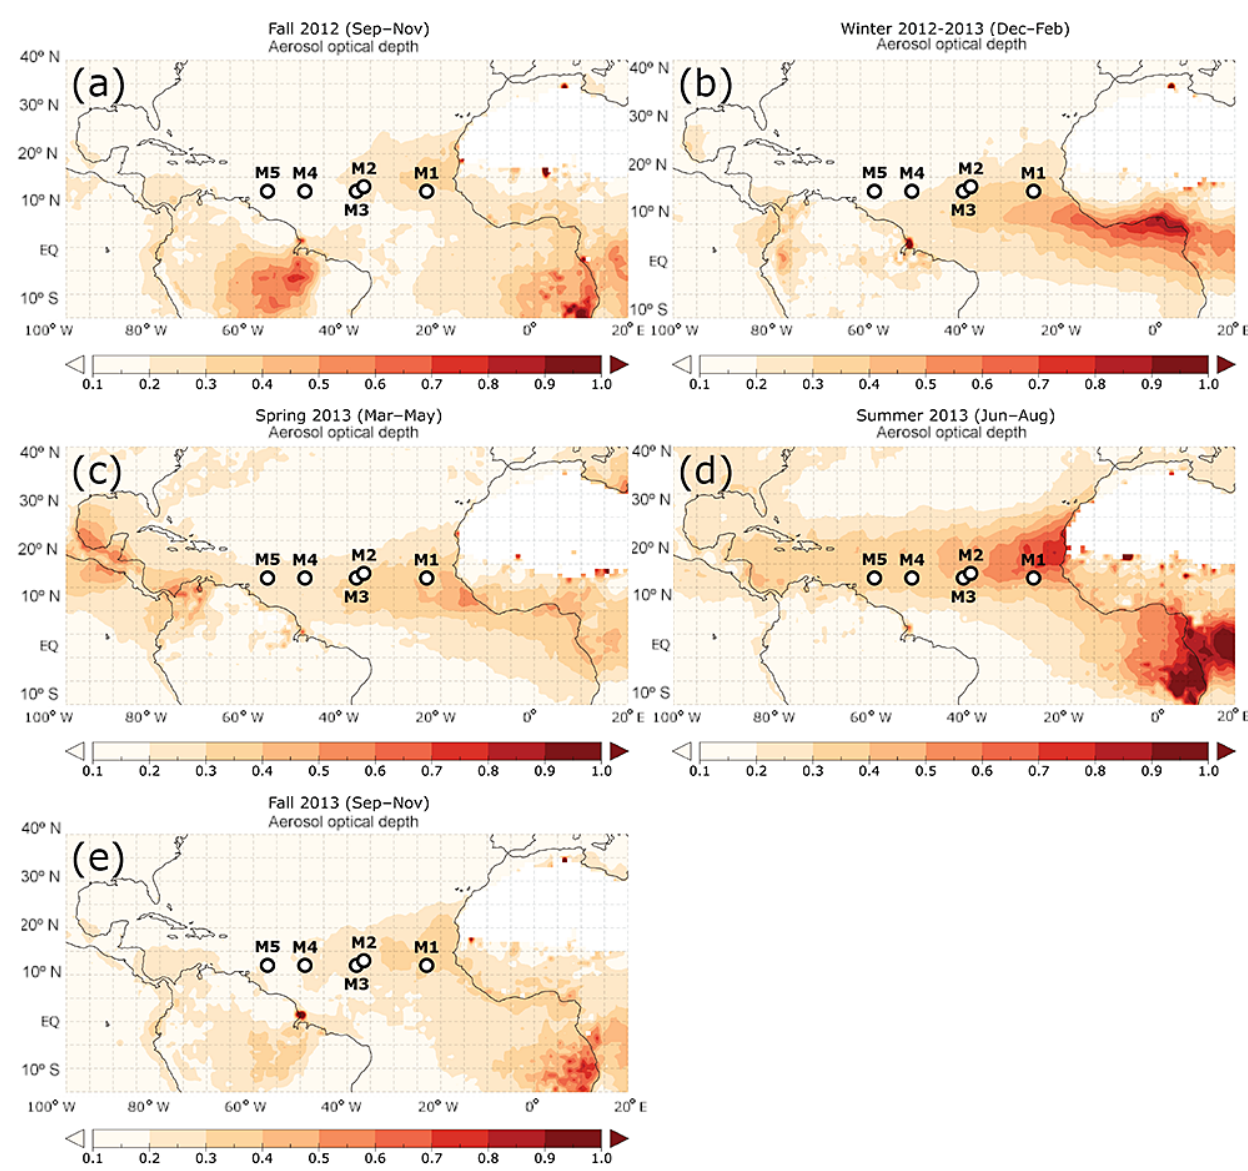
Figure 8. Three-month average aerosol optical depth (AOD) for the sampled seasons, from MODIS Terra. (a) Fall 2012 (SON), (b) winter 2012–2013 (DJF), (c) spring 2013 (MAM), (d) summer 2013 (JJA), and (e) fall 2013 (SON). Stations M1–M5 are marked with white-filled black